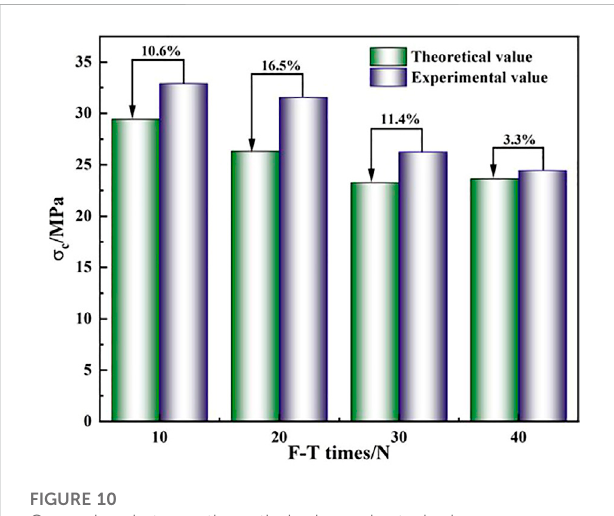
FIGURE 10 Comparison between theoretical value and actual